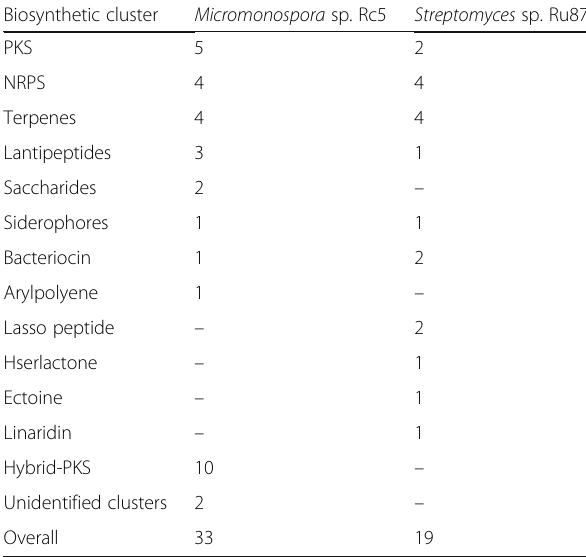
Table 2 Predicted secondary metabolite biosynthetic gene clusters recorded by Micromonospora sp. Rc5 and Streptomyces sp. Ru87 whole genomes analyzed using the antiSMASH 3.0.5 database Biosynthetic cluster Micromonospora sp.